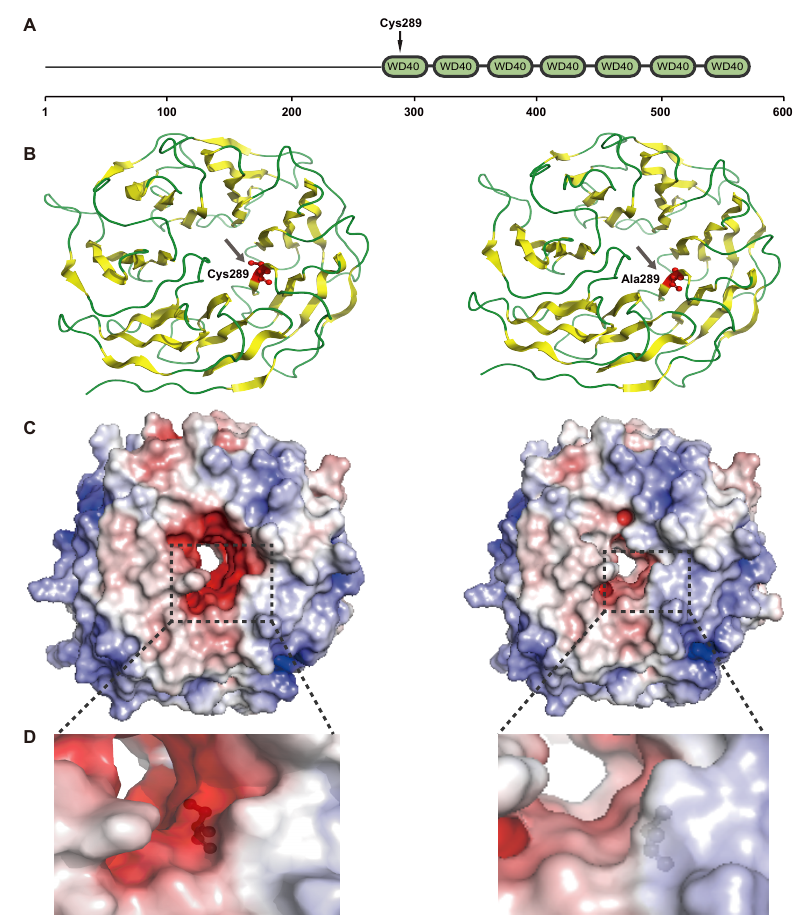
Figure 3. Structure of PRPF17 protein sequence of the P. acdestis (left) and S. montelus (right), respectively. ( A ): The PRPF17 protein domain with seven repeated WD40 motifs; the candidate positively selected site is indicated by black arrow. ( B ): The structures of sheet and loop are shown in yellow and green, respectively, with the positively selected residues shown with the red ball and stick representation. ( C ): Electrostatic potential map of PRPF17 domain; the range of electrostatic surface potential is shown from − 7 kT / e (red color) to + 7 kT / e (blue color). ( D ): The zoomed-in picture of electrostatic potential around the positively selected residues. Template in the Protein Data Bank: